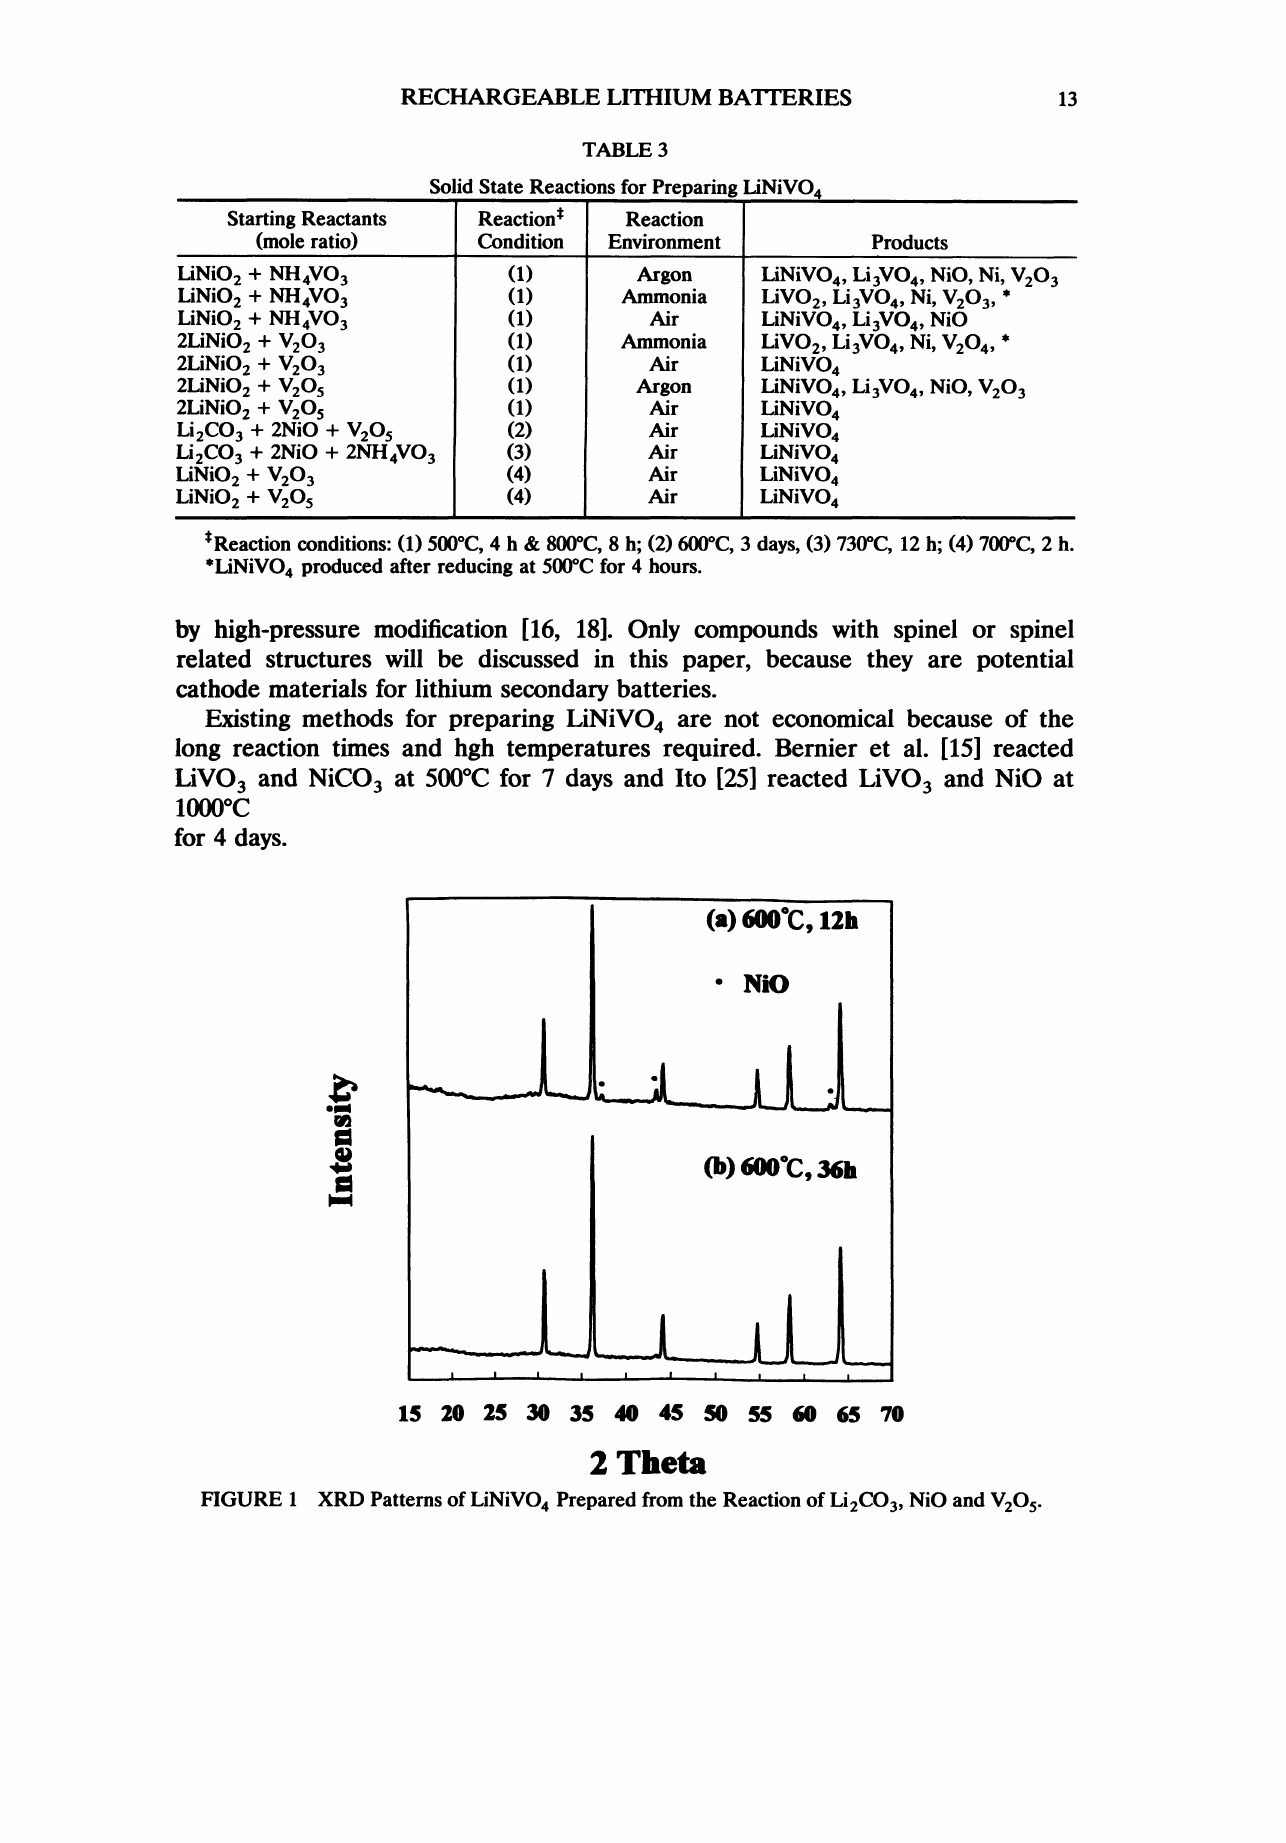
Solid State Reactions for Preparing LiNiVO